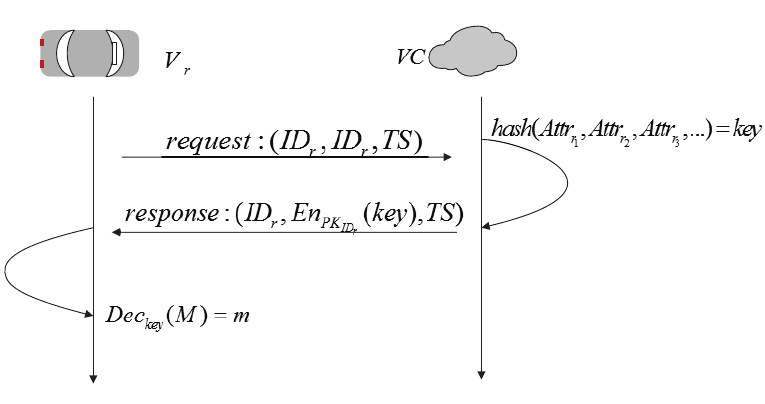
Figure 4. Decryption